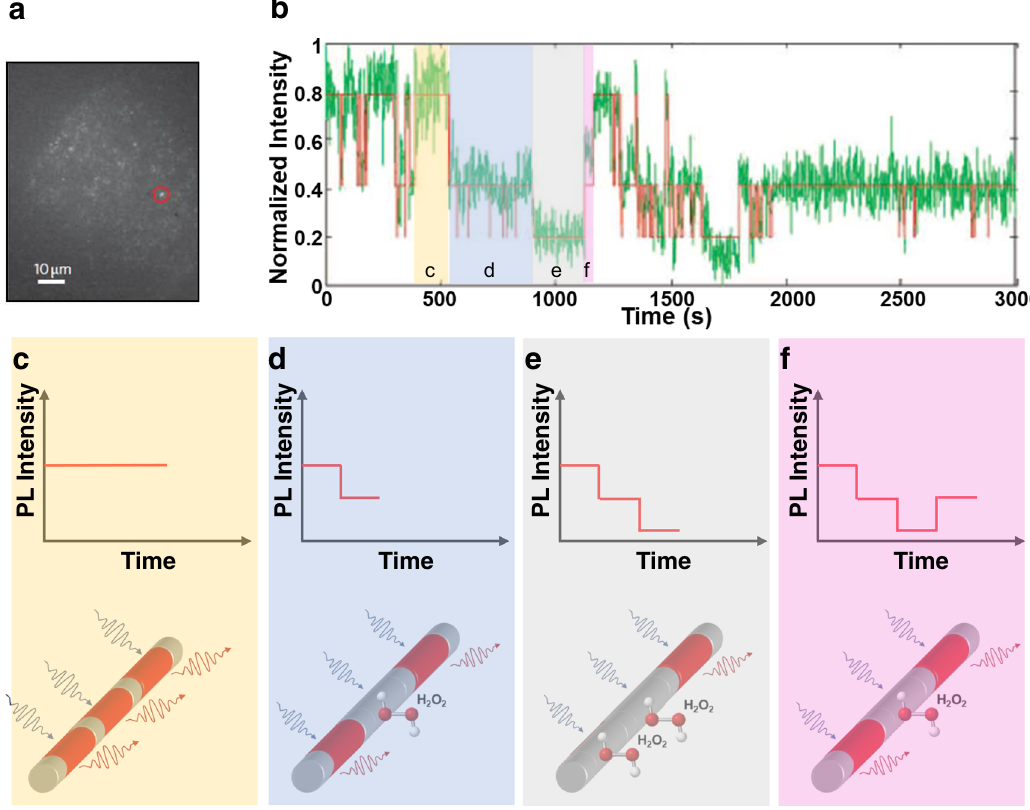
Fig. 8 Single-molecule detection of H 2 O 2 by stepwise quenching of individual SWNTs. a Near-infrared image of SWNTs under A431 cells. b Single- molecule tracking (green) performed by measuring the fl uorescence of single sensors and monitoring step-changes in fl uorescence, which can be fi tted to a hidden Markov algorithm (red) to identify single binding and release events. Adapted from ref. 117 with permission. c A single nanotube (bottom) consists of multiple regions, where each state is either quenched or unquenched. The nanotube fl uorescence intensity varies over time upon single-quencher molecular binding events. When unquenched, the fl uorescence state at a particular region of the SWNT results in a nanotube fl uorescence intensity value. d The adsorption of quenching H 2 O 2 molecule results in a single-state quenching event, and a stepwise decrease in overall SWNT intensity. e Adsorption of another quenching molecule leads to a further decrease in overall intensity. f Desorption of H 2 O 2 from the SWNT surface recovers the nanotube fl uorescence with a stepwise increase in